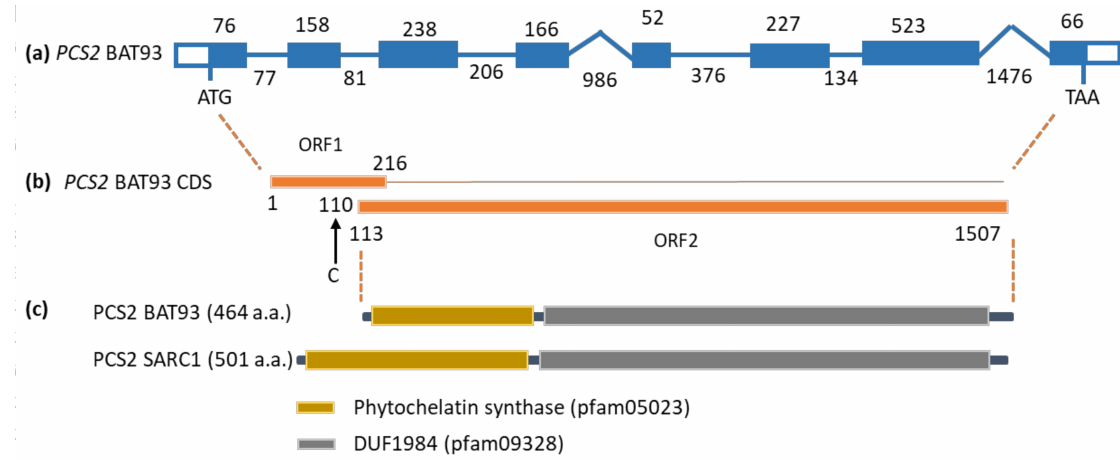
Figure 4. Naturally occurring variant of PCS2 in BAT93. ( a ) Intron–exon structure of the BAT93 PCS2 gene. The length of introns and exons is indicated starting from the first translation initiation codon and ending at the stop codon. ( b ) The gene gives rise to two open reading frames, due to the insertion of a cytosine at position 110 of the coding sequence (CDS), which results in a premature stop codon. Corresponding positions in the cDNA with respect to the first initiation codon is indicated. ORF1 encodes a predicted polypeptide of 71 amino acids. ( c ) Due to the insertion, PCS2 encoded in BAT93 represents a shorter form translated from an alternative, downstream start codon as compared with PCS2 encoded by SARC1, SMARC1N-PN1 and the reference bean genome, G19833. Pfam domains present in the phytochelatin synthase sequence are indicated.